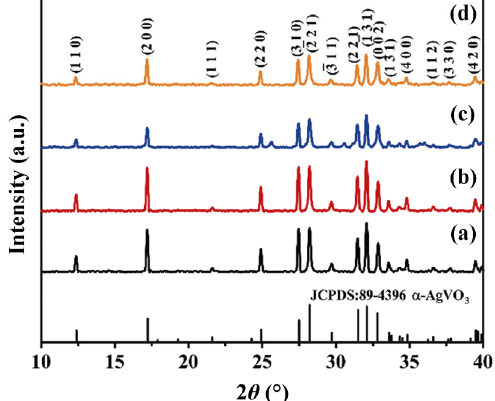
Fig. 3 XRD patterns of (a) α -AgVO 3 , (b) 0.5 GO/ α -AgVO 3